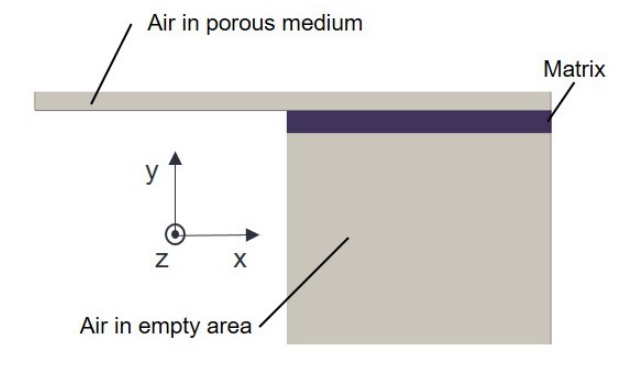
Figure 5. Two-phase flow with matrix and air at the start of rotational molding.